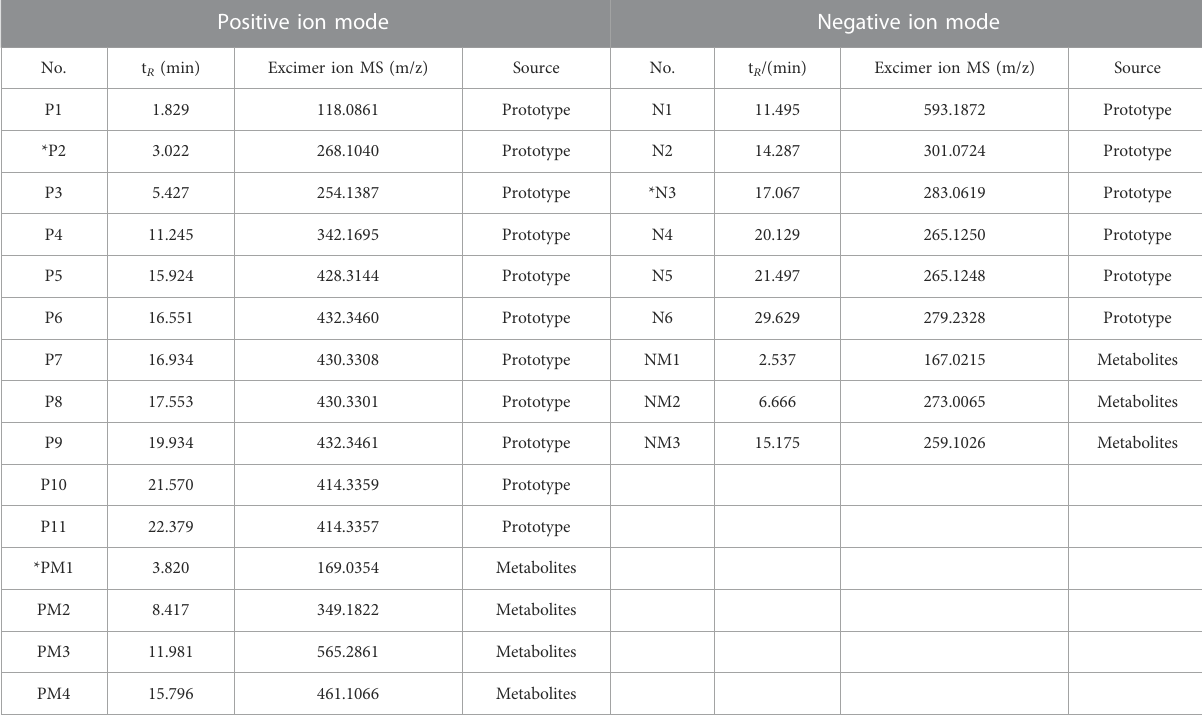
TABLE 1 Analysis on chemical components absorbed in healthy rat plasma. Positive ion mode Negative ion